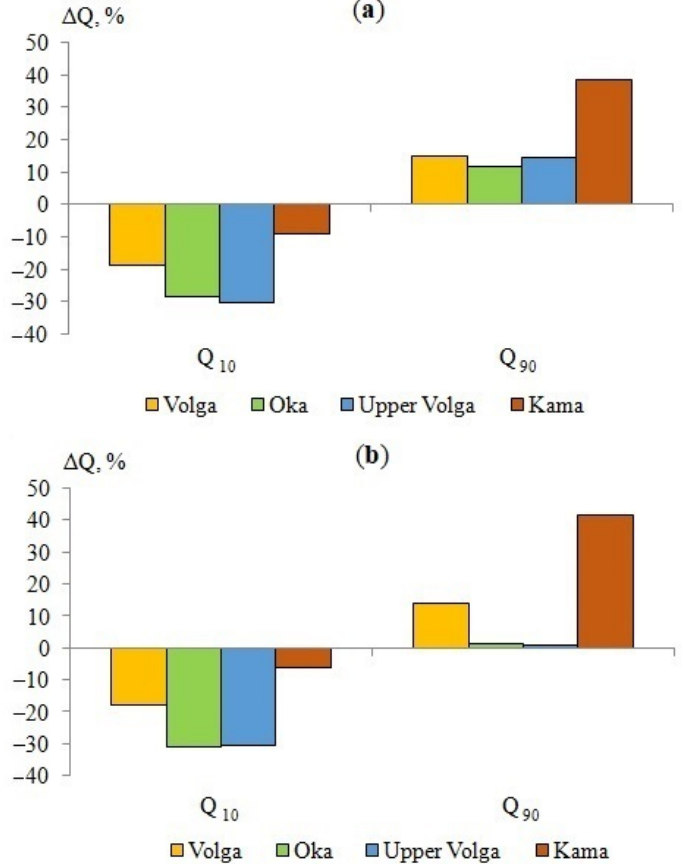
Figure 11. Anomalies of high (Q 10 ) and low (Q 90 ) flow of the Volga, Oka, Upper Volga and Kama rivers under global warming by 1.5 °C ( a ) and 2 °C ( b ) in the 21 st century relative to the baseline period 1970–1999.